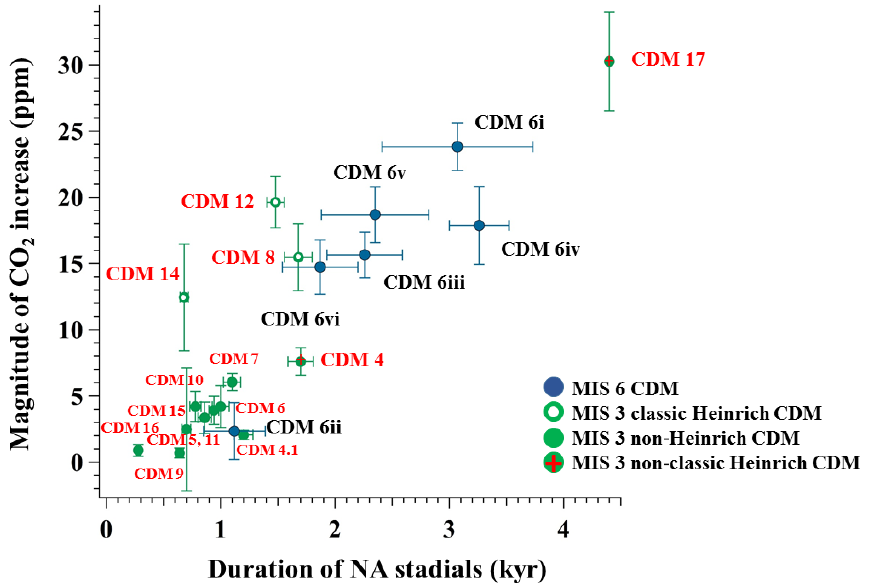
Figure 7. The relationship between NA stadial duration and magnitude of CO 2 increase. Green dots indicate non-Heinrich CDM events during MIS 3, green circles indicate classic Heinrich CDM events during MIS 3 and red-filled green circles indicate non-classic Heinrich CDM events during the MIS 3 period. Blue dots indicate CDM events during MIS 6. Non-classic Heinrich events are defined as ice discharge events with different IRD source signatures from Heinrich events, occurring at transitions in NH ice